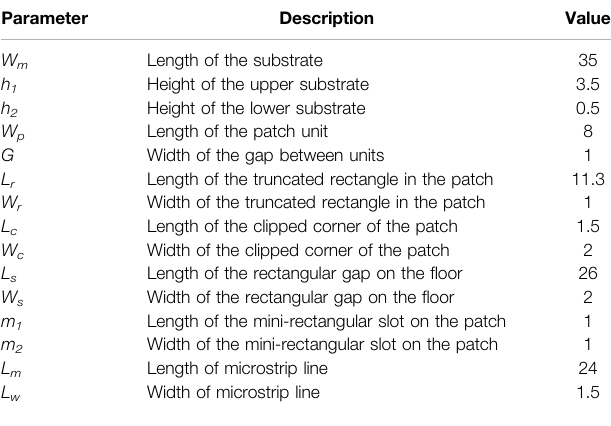
TABLE 1 | Parameters of the proposed antenna (in